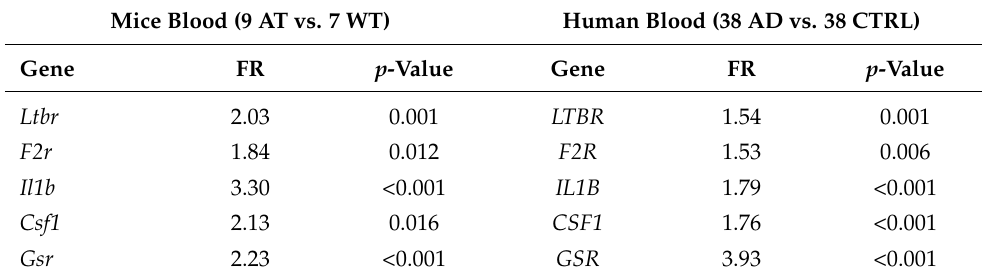
Table 2. Gene expression changes in the blood of AT mice and mild AD patients [24]. Results are expressed as FR values. Only the genes with FR > 1.8 ( p < 0.05) in mice are represented. Comparisons between diseased individuals (patients or mice) and the corresponding age-matched controls were made using the Mann–Whitney U-test; differences were considered significant for p <